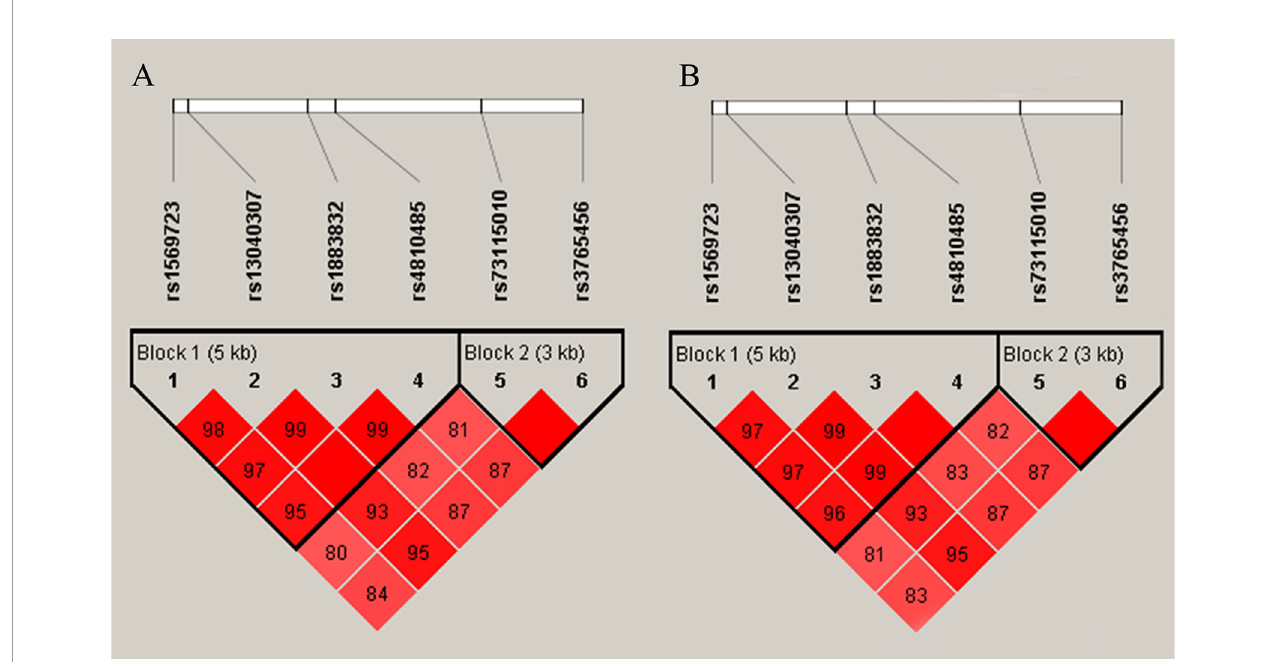
FIGURE 1 | Linkage disequilibrium(LD) of six single nucleotide polymorphisms. The intensity of linkage disequilibrium (LD) is re fl ected in the color and numeric value (D ′ ) of each box. Bright red means D ′ ≥ 0.95, LOD ≥ 2. Shade of red means D ′ <0.95, LOD ≥ 2. (A) LD of RA patients and controls. (B) LD of SLE patients and controls. Both of them show that block 1 consists of four polymorphisms including rs1569723 A/C, rs13040307 T/C, rs1883832 T/C, and rs4810485 T/G, block 2 consists of rs3765456 A/G and rs73115010